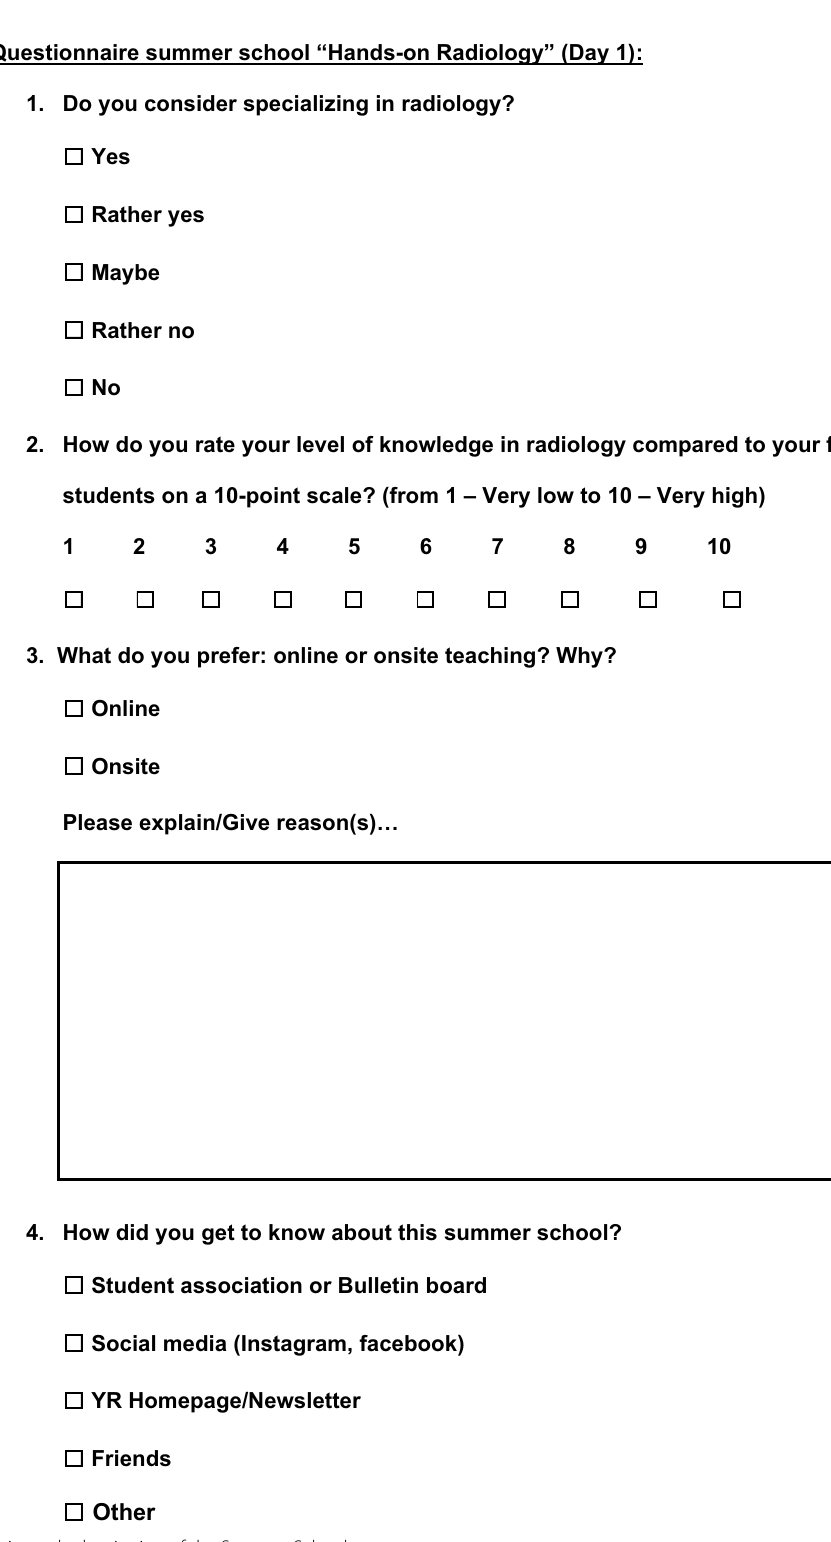
Fig. 1 Questionnaire at the beginning of the Summer